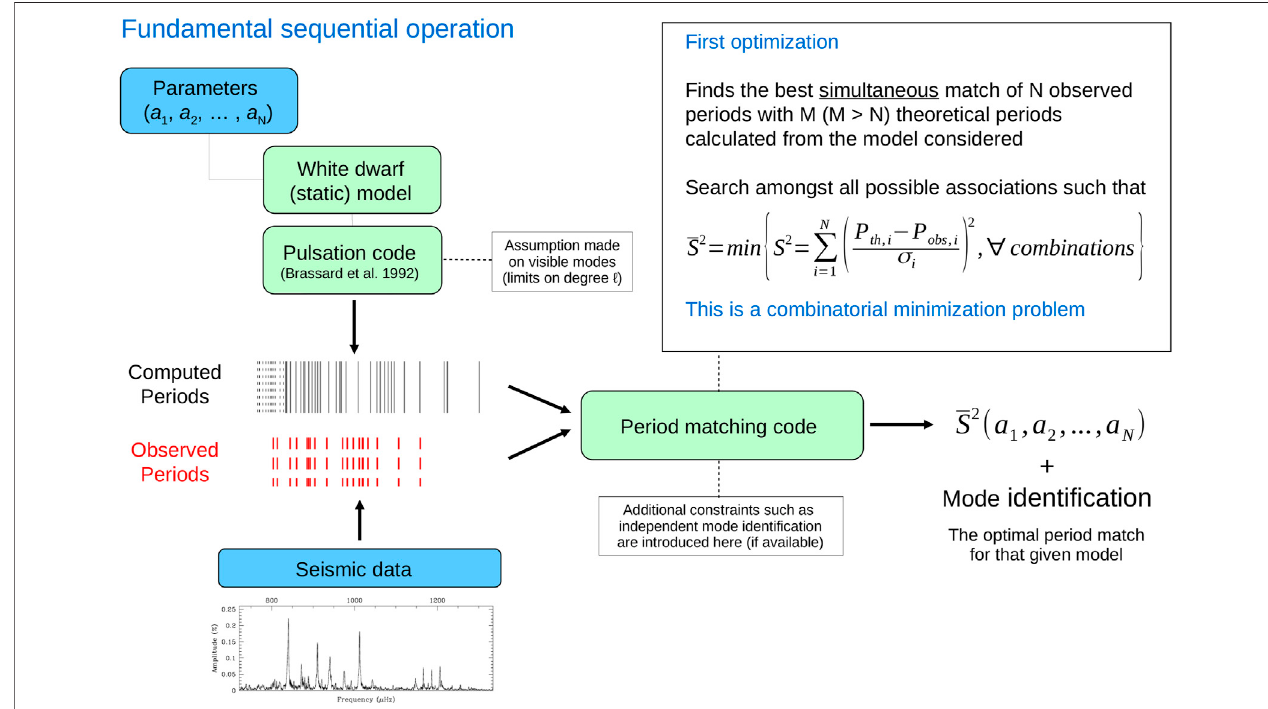
FIGURE 1 | Schematic representation of the fundamental operation (a sequential chain of calculations) that enters our double optimization scheme. The observed pulsationperiodsareoptimallymatched(througha fi rstcombinatorialoptimization),takingexternalconstraintsintoaccount(ifany),withperiodscomputedforamodelof given parameters. The quality of fi t is quanti fi ed using a χ 2 -type merit function. This quantity, (cid:2) S 2 , is then viewed as a function of model parameters a 1 , a 2 , ... , a n and is further minimized in this multi-dimensional space (the second optimization).